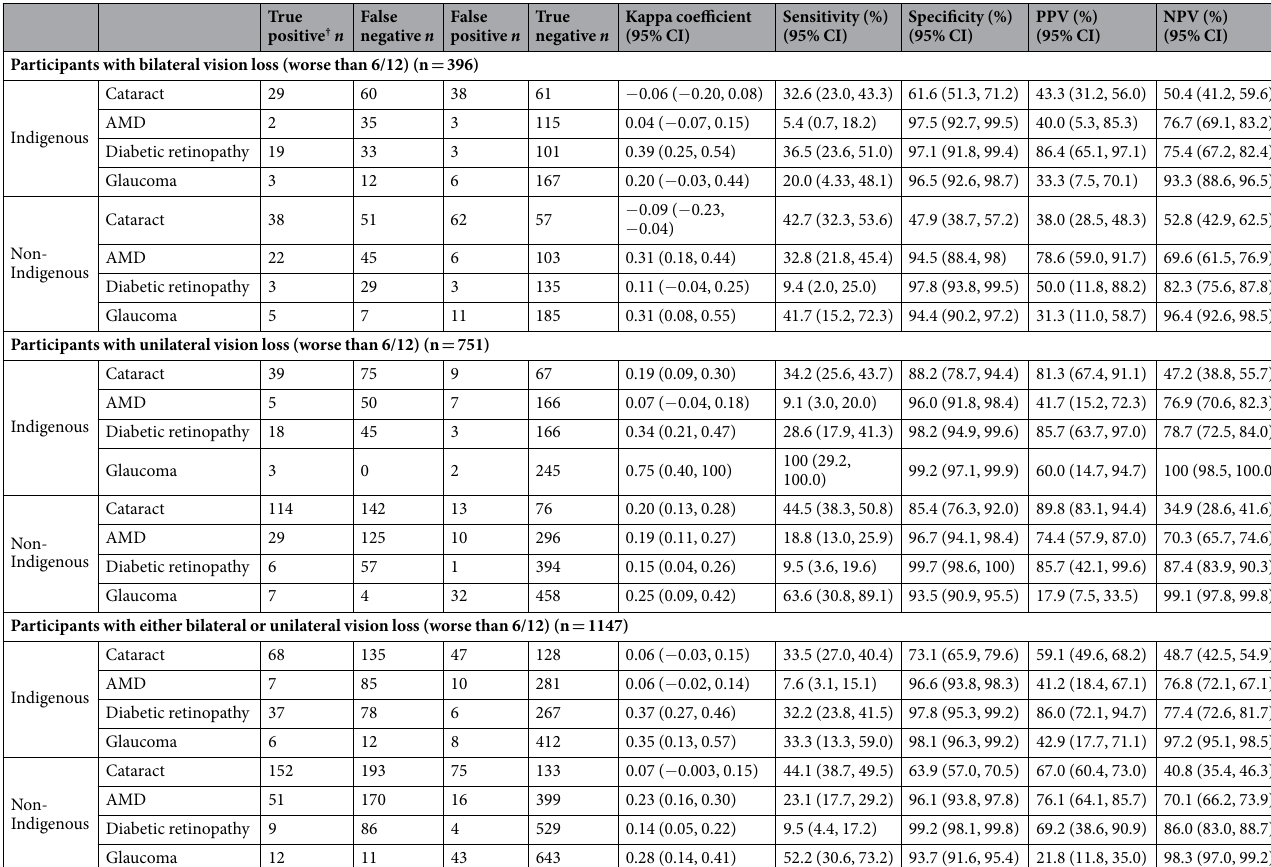
Table 2. The reliability of self-report of four leading causes of vision loss by Indigenous and non-Indigenous Australians with vision loss † True positive: self-report = yes, examination = yes; False negative: self-report = no, examination = yes; False positive: self-report = yes, examination = no; True negative: self-report = no, examination = no 95% CI = 95% Confidence Interval. PPV = Positive Predictive Value. NPV = Negative predictive value. AMD = Age-related macular